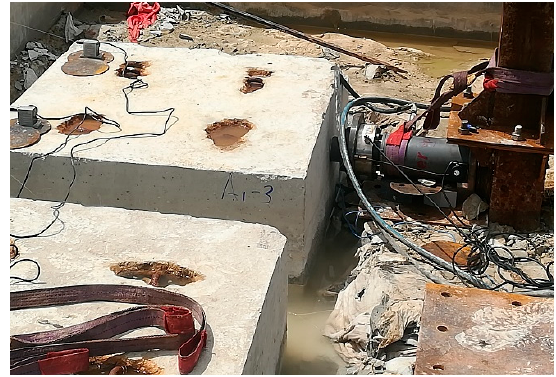
Figure 6. Horizontal loading device for simulation test.